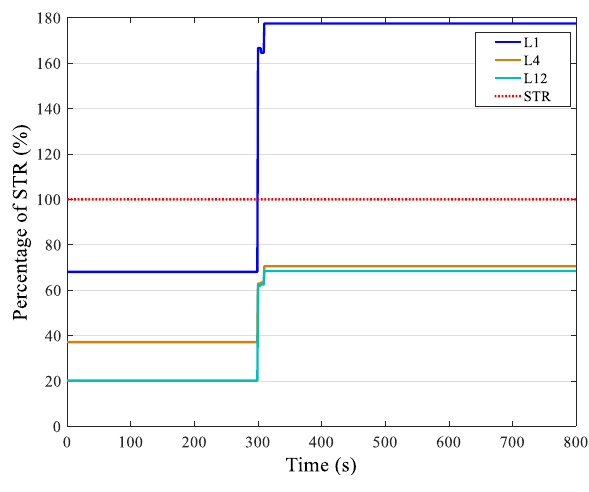
Figure 9. Current variation of fault 3.